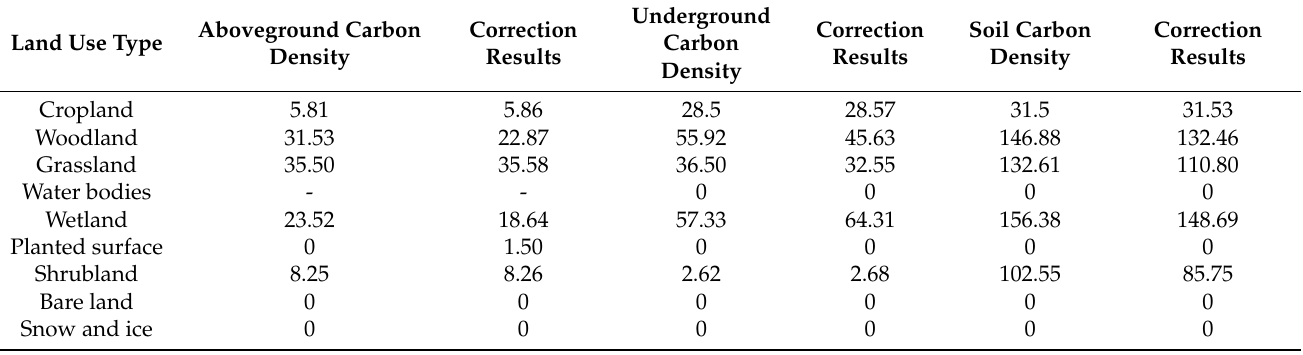
Table 1. Carbon density and correction table for each land use component of Zoig ê alpine grassland (unit: